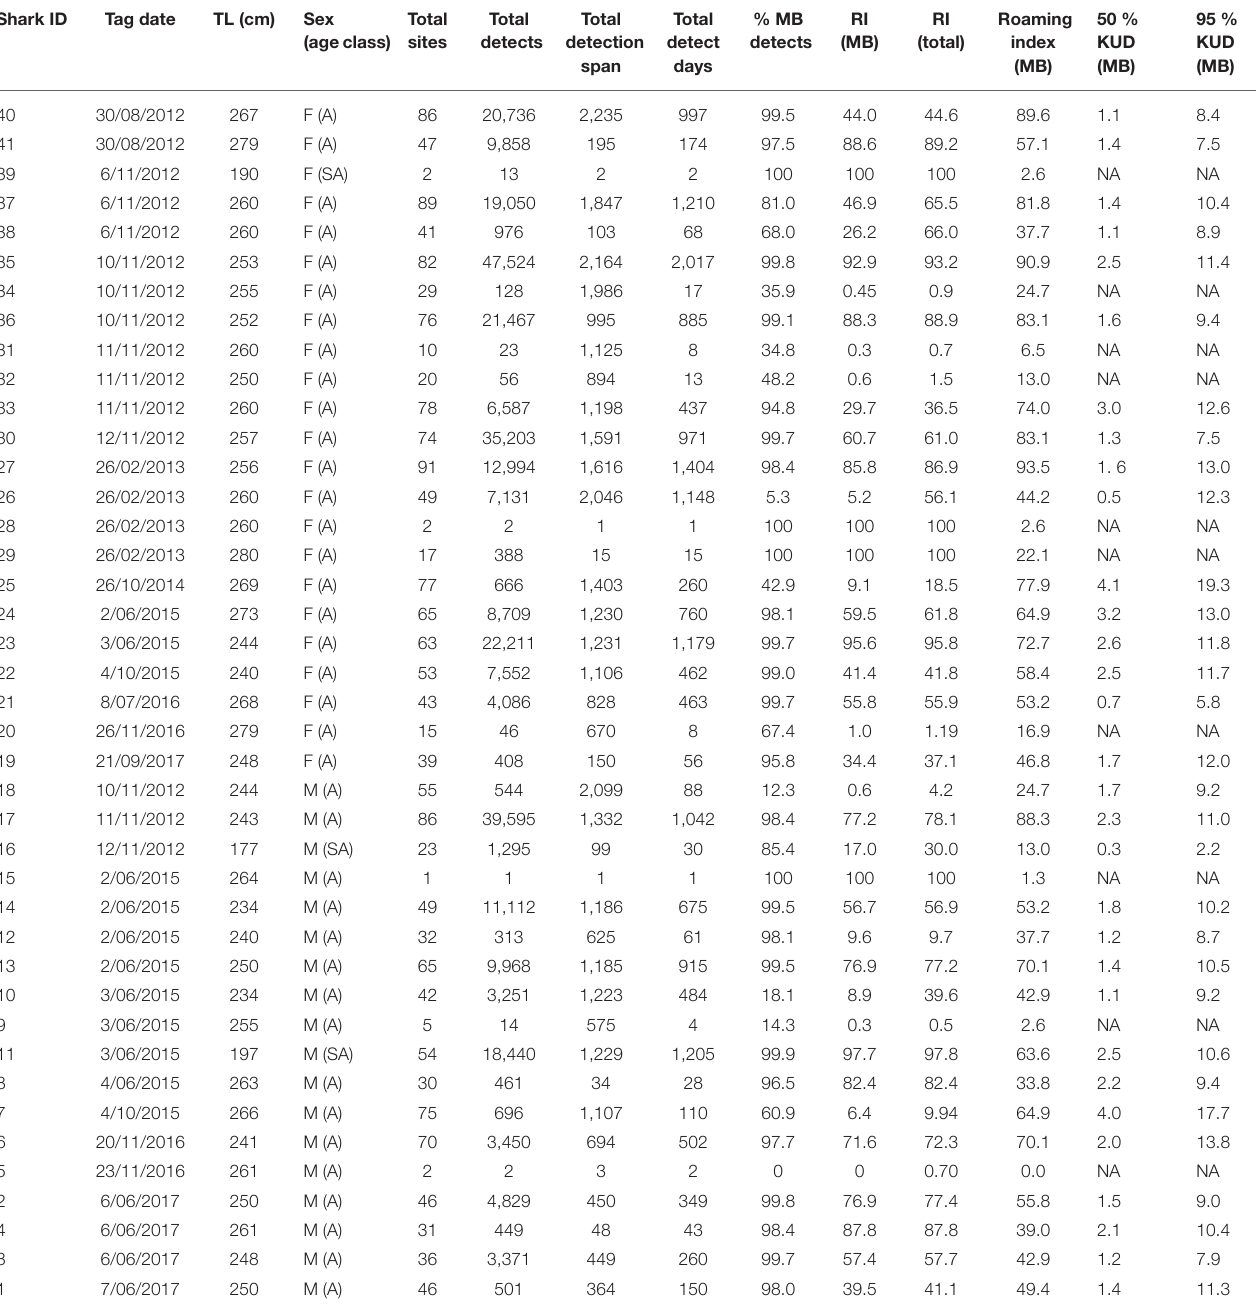
TABLE 1 | Summary of individual tag identification (Tag ID), tag date, Total length [TL (cm)], sex and age class (A = adult, SA =